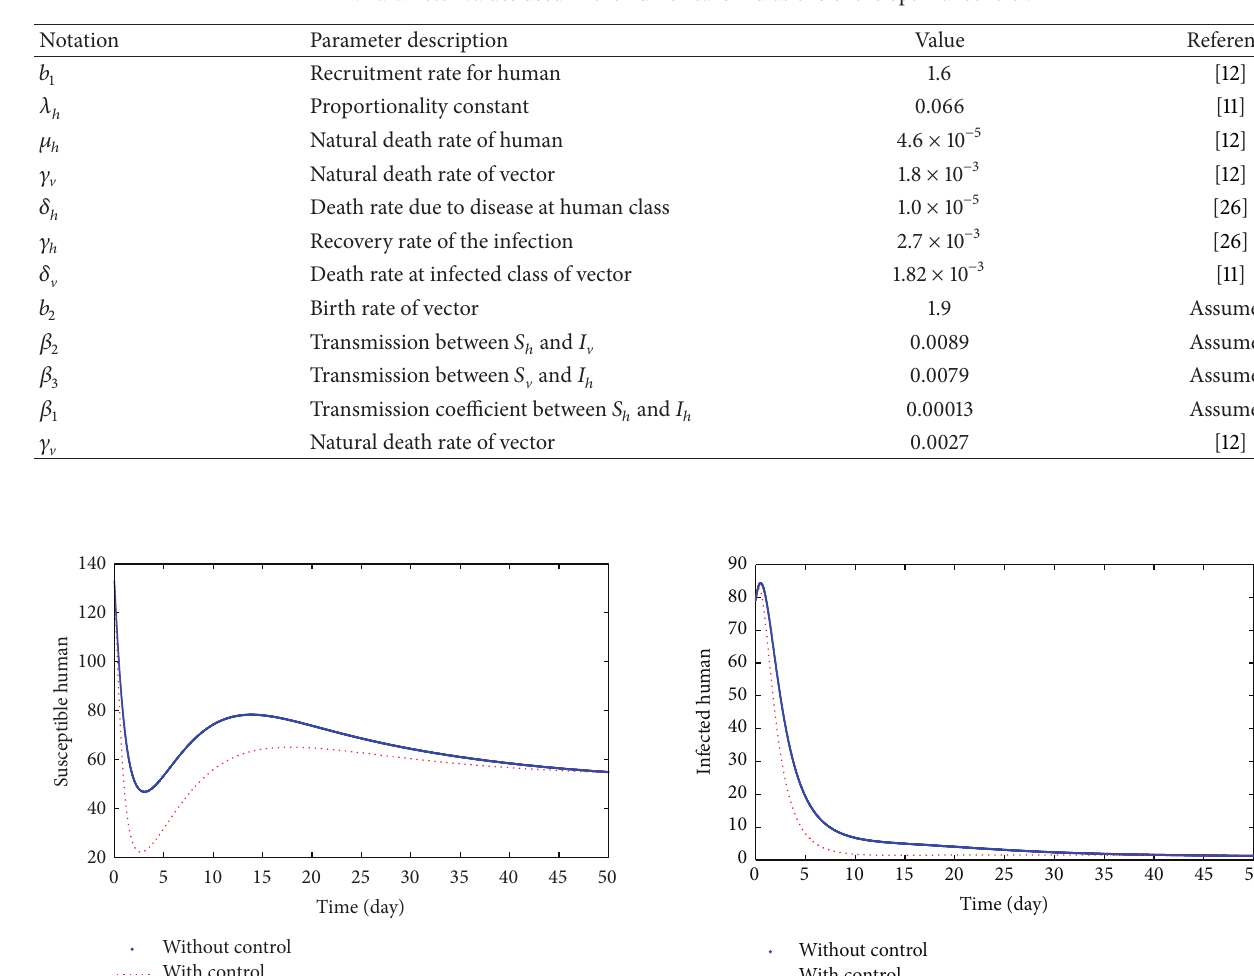
Table 2: Parameter values used in the numerical simulations of the optimal control.